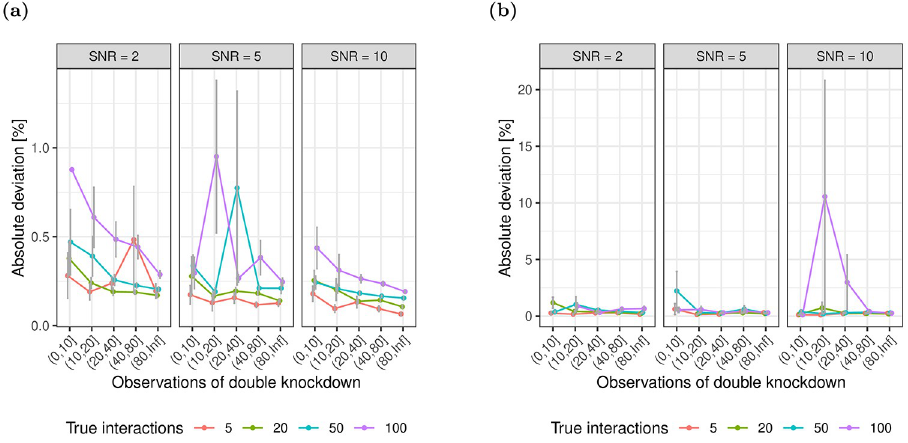
Fig 7. Concordance between the sign of true and estimated epistasis. The fraction of incorrectly identified signs between true and estimated epistasis for (a) glinternet and (b) xyz .